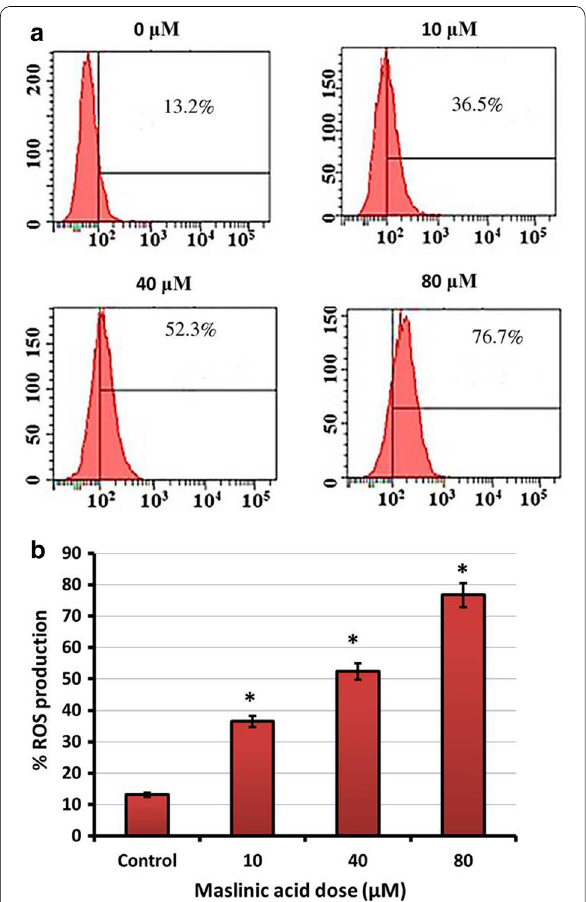
Fig. 7 a Spectrofluorometry analysis of neuroblastoma SHSY-5Y cells after probing with H 2 DCFDA and maslinic acid treatment. For analyzing of ROS production at indicated doses. b Graphical representation of outcomes from Spectrofluorometry. All the data indicated in this figure are represented as mean SD and p < 0.05 ± was considered as statistically